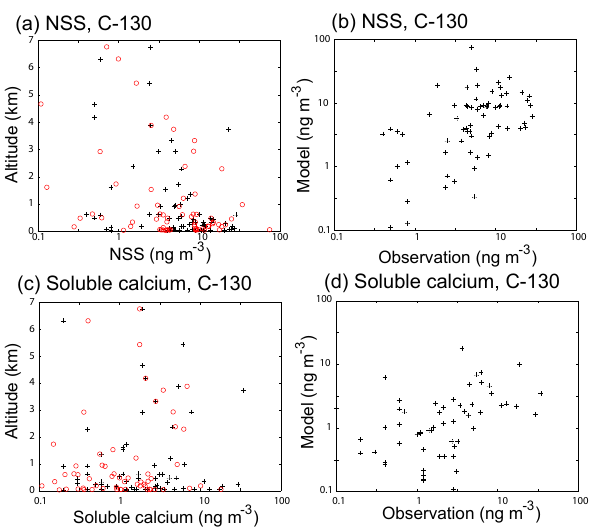
Fig. 2. Altitude distribution of simulated (red circles) versus measured (black crosses) concentration from ACE-Asia for (a) non-sea-salt sulfate (NSS) and (c) soluble calcium during April 2001. Scatter plots are also shown for (b) non-sea-salt sulfate and (d) soluble calcium.